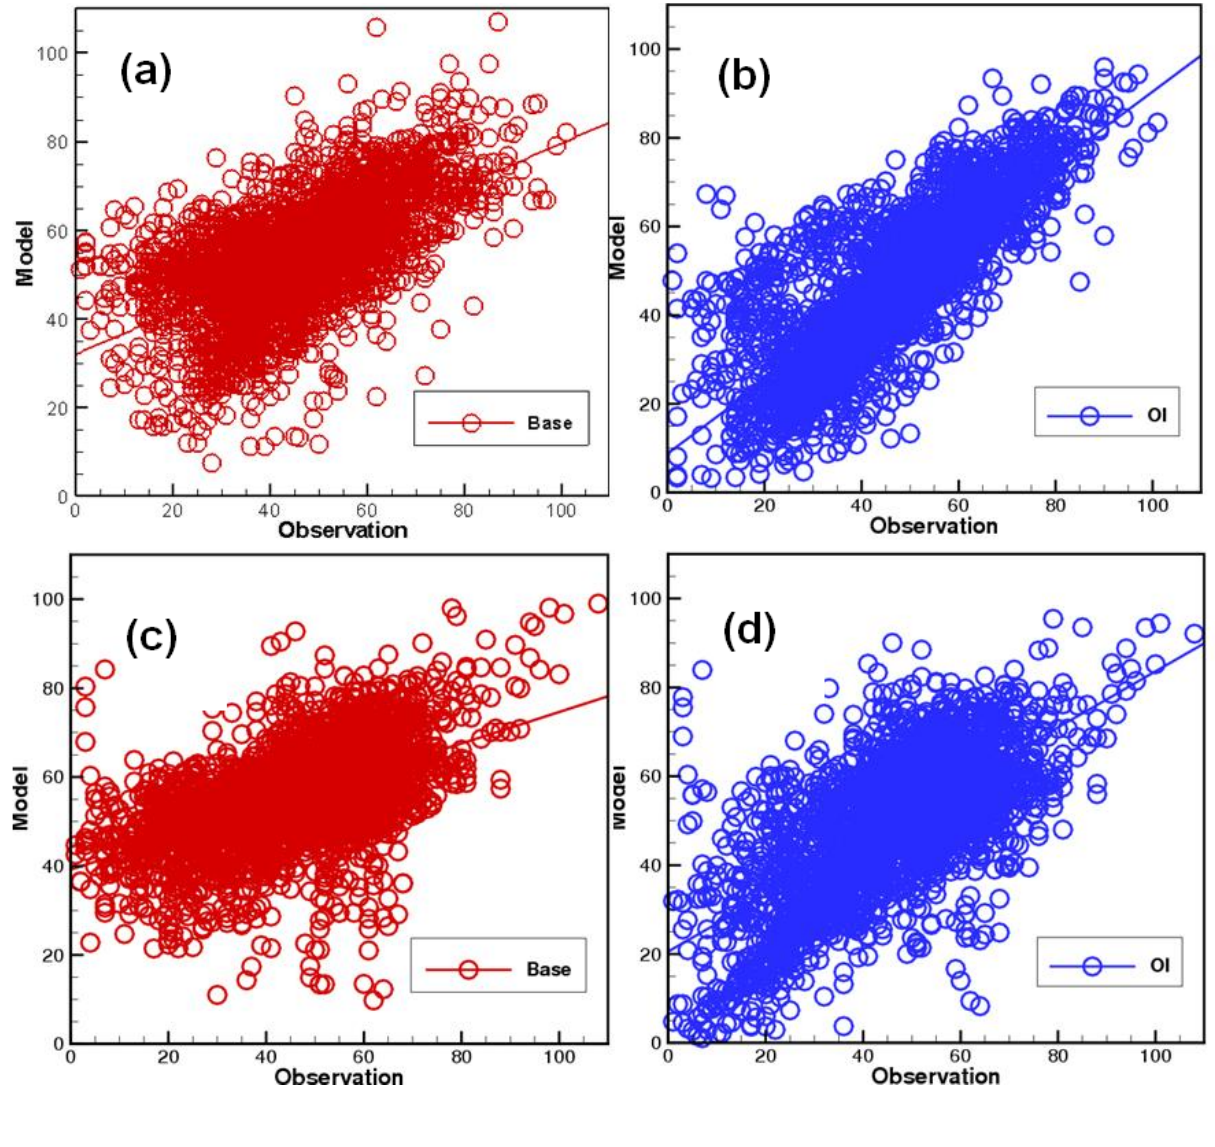
Figure 3. Scatter plots of AIRNow ozone observations and CMAQ predictions for the assimilation (upper, ( a ) and ( b )) and hindcast (lower, ( c ) and ( d )) period of the base (left, (a) and (c)) and OI assimilation (right, (b) and (d)) runs. (a) and (b): 1300-2400Z on August 5, 2007; (c) and (d): 1300-2400Z August 6, 2007. Correlation coefficients are 0.59, 0.81, 0.56, and 0.68 for (a), (b), (c), and (d) plots,